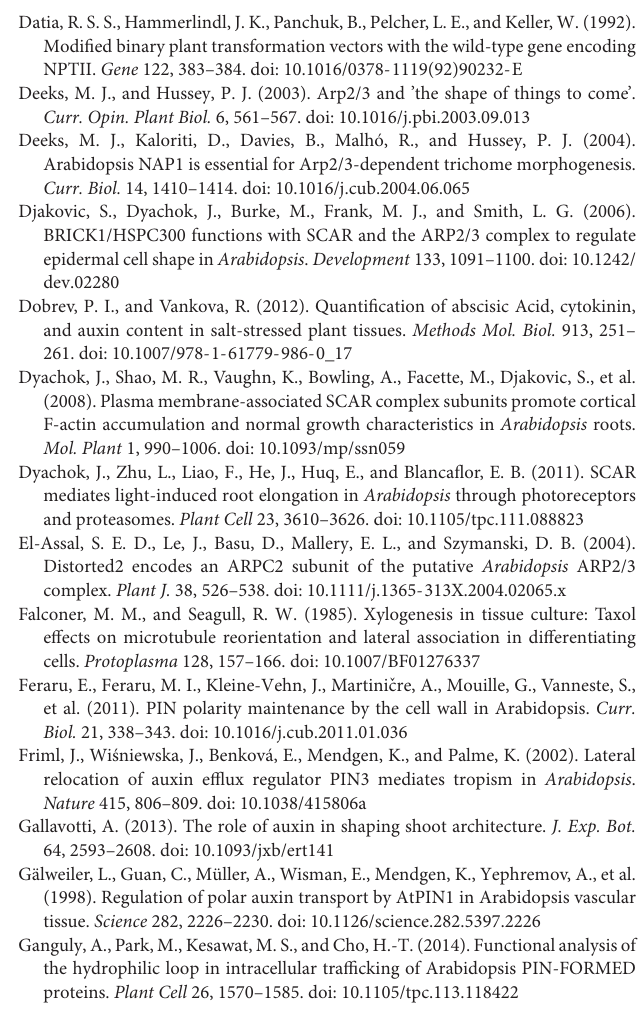
FIGURE 1 | Cross section of a root of pARP2::GUS line. GUS reporter was visualized in 7 DAG plants as described in Materials and methods. Roots were then embedded into 2.5 % agarose. Agarose block was fixed to a holder of vibratome and sectioned to obtain root cross sections of a thickness of 50 µ m. Sections were observed using Olympus Provis AX 70 microscope. GUS reporter expressed within the vascular bundle is focused in regions corresponding to phloem cells (Dinneny and Yanofsky 2004). P, phloem; X, xylem. Scale bar = 20 µ m. FIGURE 2 | (A) Immunostaining of PIN1 in longitudinal stem sections five-week-old wild-type plants and plants lacking functional ARP2/3 complex ( arp2, arpc4 and arpc5 ) showing disturbed localization of PIN1 at the basal end xylem parenchyma cells. Scale bar = 20 µ m. (B) Detail of the squared area in (A) (scale bar = 5 µ m, three biological replicates). FIGURE 3 | (A) Vacuolar organization in wild-type and arpc5 plants at 5DAG, 9DAG and 14DAG. (B) Vacuolar occupancy quantifications at three-way cellular junctions of cotyledons stained overnight with 4 µ M FM4-64 at multiple growth timepoints (5DAG, 9DAG and 14DAG) for Col-0 and arpc5 . S (Pairwise comparisons with Student’s t -test; ∗∗ p < 0.01; three biological replicates). Scale bar = 50 µ m. FIGURE 4 | Vacuolar organization in wild-type and arp2, arpc4 and arpc5 in 1DAG cotyledon expressing the lytic vacuole γ TIP-mCherry marker. Scale bar = 10 µ